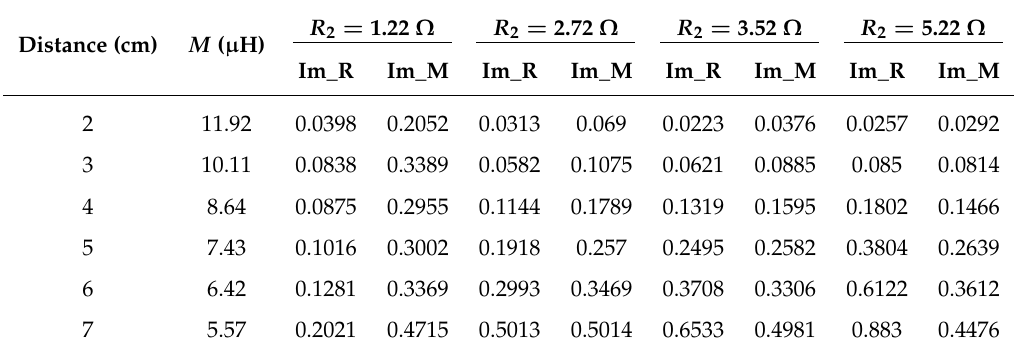
Table 4. Imaginary parts of R 2 and M in the simulation.